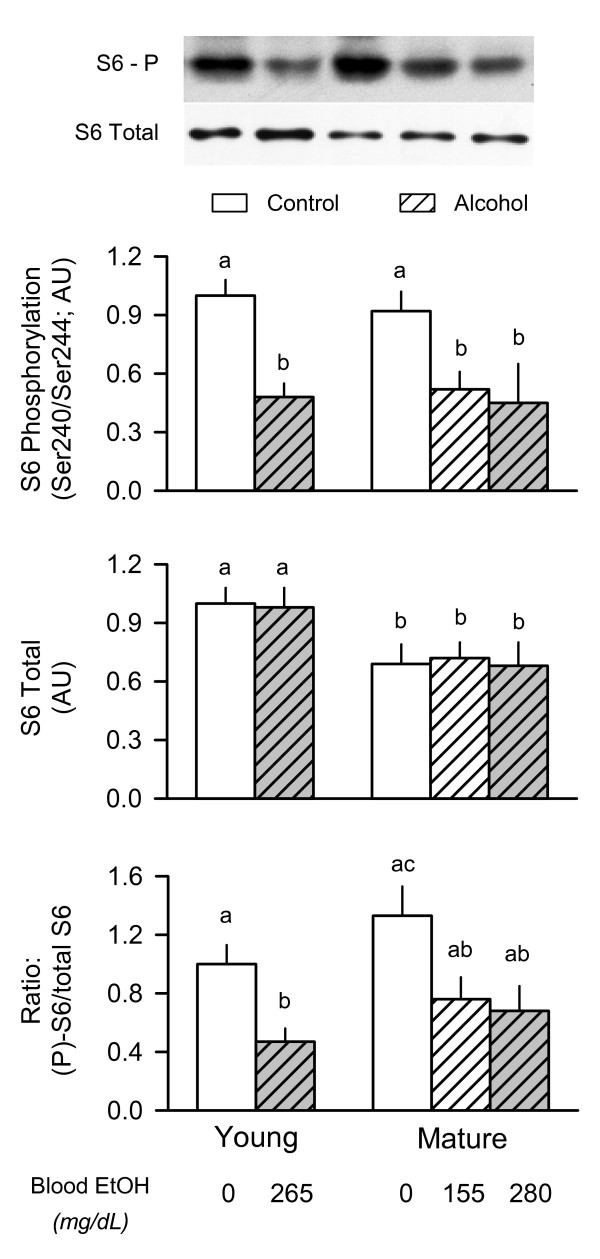
Effect of acute alcohol intoxication on the total amount and phosphorylation of ribosomal protein S6 in skeletal muscle from young and mature rats. Groups are the same as described in Figure 1. Gastrocnemius was collected 2.5 h after administration of alcohol or saline (control). Insert at top: representative Western blots of Ser240/Ser244-phosphorylated (P) S6 and total S6 protein in muscle. Top and middle graphs: densitometric analysis of immunoblots of Ser240/244-phosphorylated S6 and total S6, respectively. Bottom graph: ratio of phosphorylated (P) to total S6 protein in muscle. Values (means ± SEM) are expressed relative to the young saline-treated control group. Sample size was 10, 10, 6, 7, 9, and 9 for the six groups, respectively. Values with different letters are significantly different from each other, P < 0.05. Values which share a common letter are not statistically different.